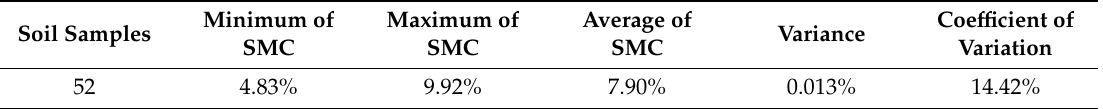
Table 2. Statistics of soil moisture content